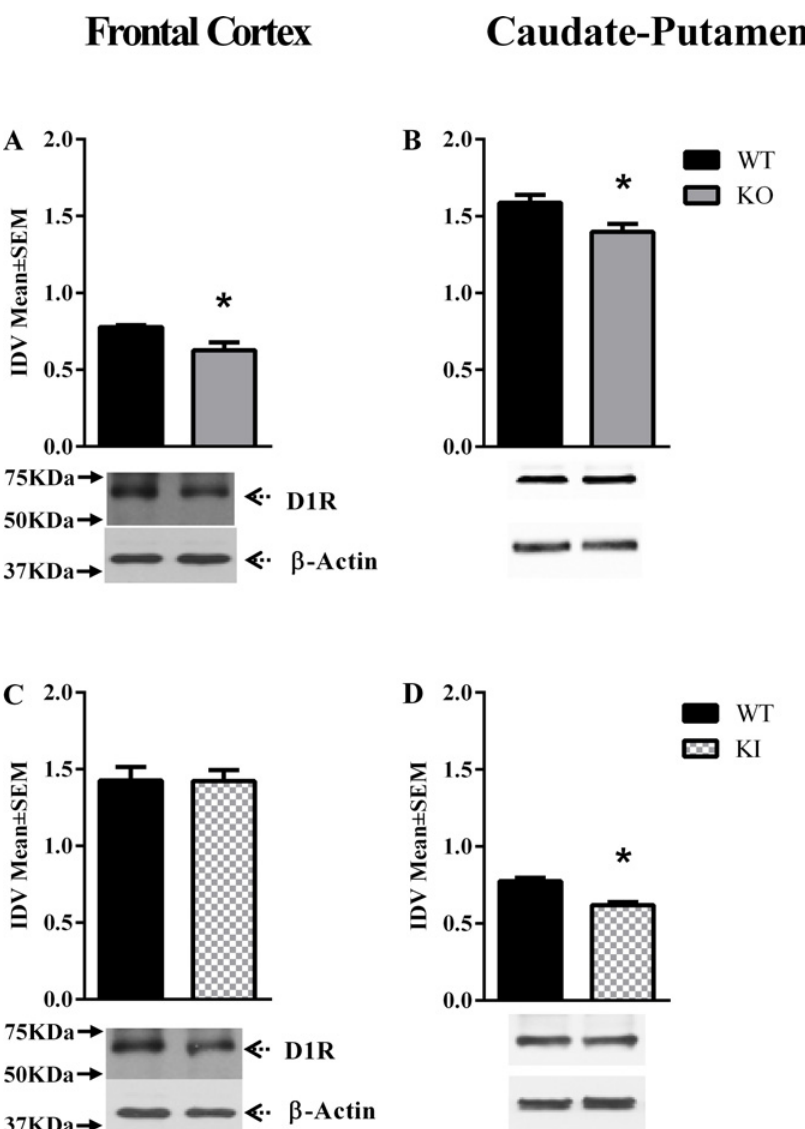
Fig 2. D1R expression at P14. D1R expression in the frontal cortex and caudate-putamen of postnatal day 14 (P14; A- D) mice. In each panel, the upper band shows D1R and the lower band shows β -actin, which was used as a loading control. The bar graphs in each panel represent D1R band intensity (mean ± SEM) normalized to intensity of the loading control (integrated density value; IDV). The names of the mouse lines ( Dyt1 KO, Dyt1 KI) are indicated to the right. ( * p < 0.05, n = 3 or